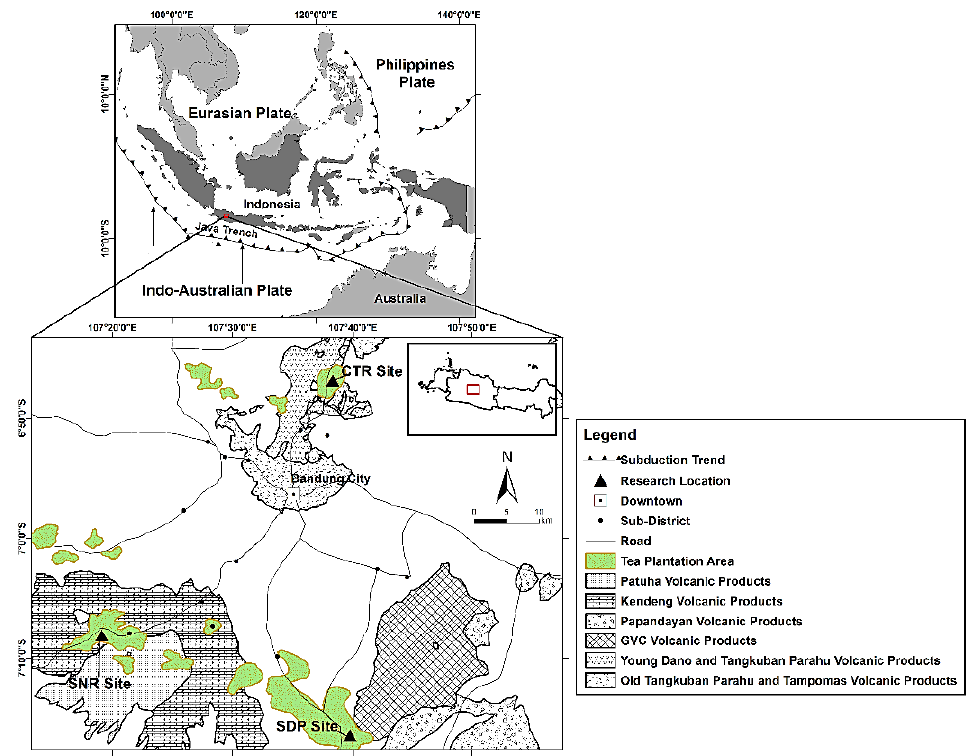
Figure 1. Study location of three estate tea plantations under six different parent materials in West Java, Indonesia.